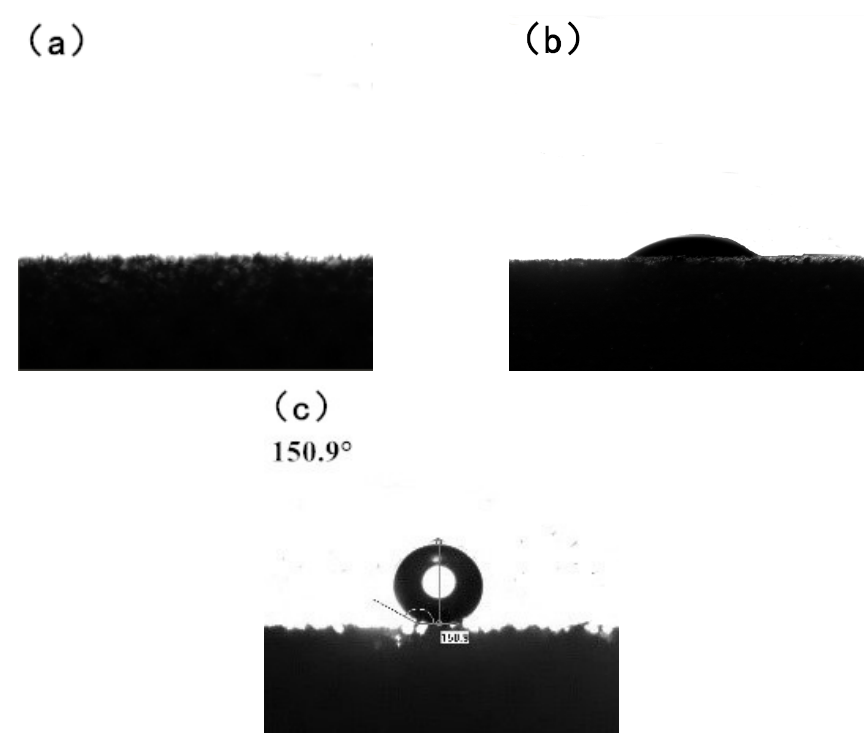
Figure 4. ( a ) MS water contact angle image, ( b ) Fe 3 O 4 /MS water contact angle image and ( c ) PDMS@Fe 3 O 4 /MS water contact angle image.